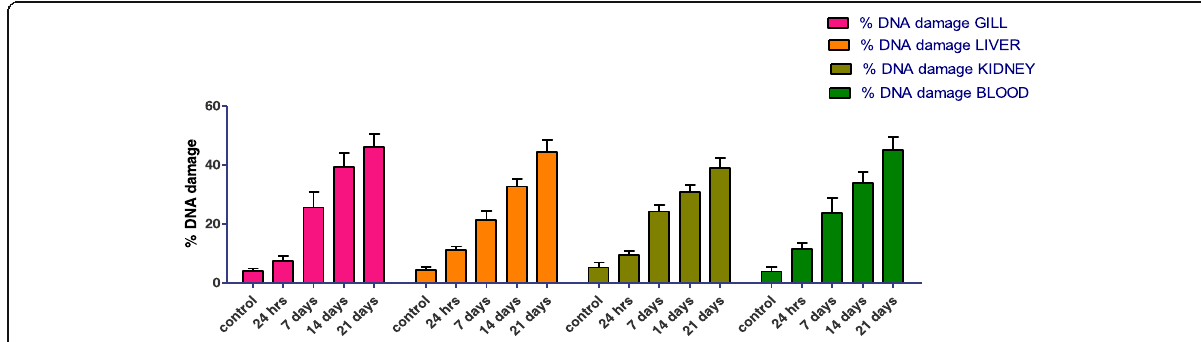
Fig. 10 % of DNA damage in tissues of C. carpio during sub-lethal exposure to karanjin